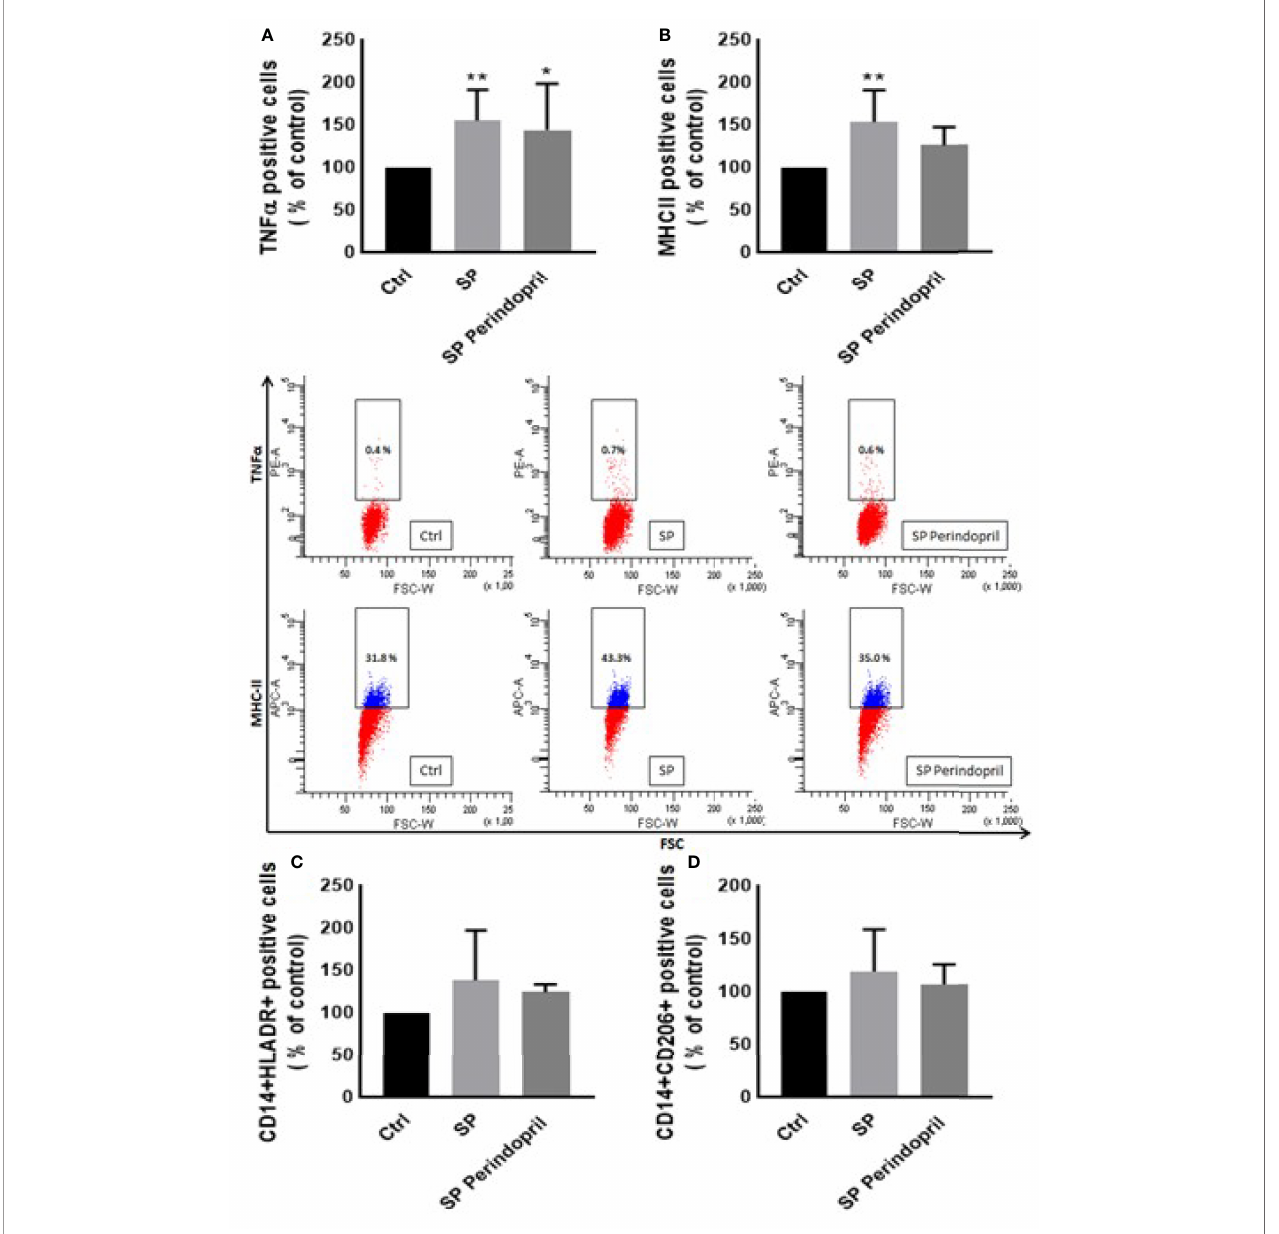
FIGURE 2 | Effects of spike (S) protein on cell polarization of THP-1-like macrophages. Thp-1 macrophages were mock treated (Ctrl), stimulated with S protein (SP) (100 µM) or SP with ACE inhibitor (SP Perindopril, 100 µM), perindopril, added 2 h before SP. After cell differentiation, the effect of SP stimulation on (A) TNF a , (B) MHCII, (C) HLA-DR, and (D) CD206 expression was measured by fl ow cytometry. The data are presented as mean ± SEM, n = 4 – 5. Ordinary one-way ANOVA followed by Dunnett ’ s test * p < 0.05, ** p <